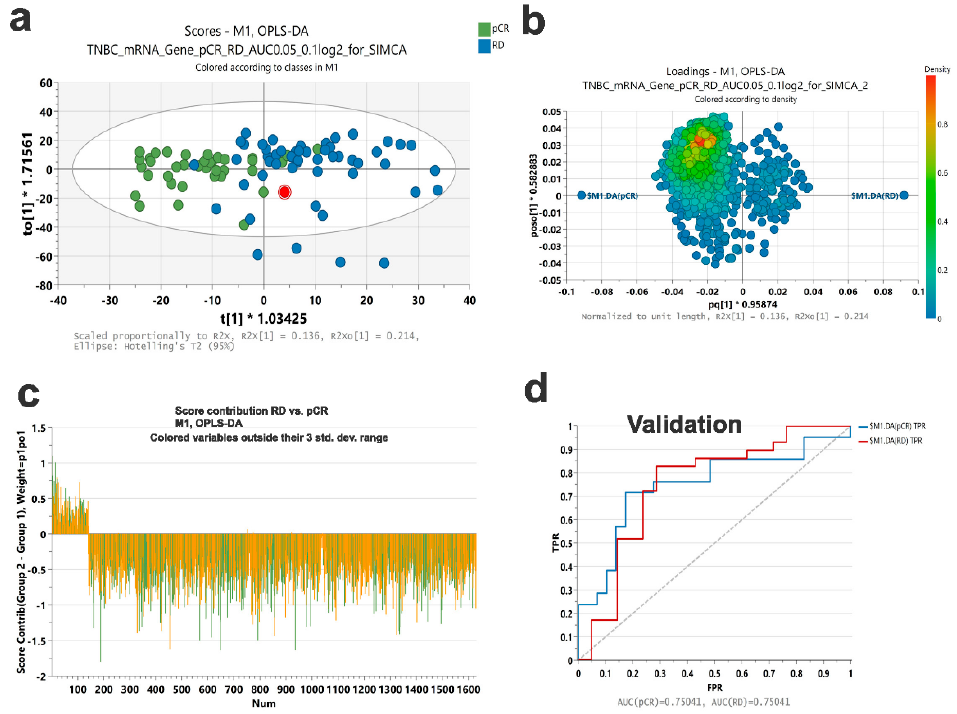
Figure 5. Validation of a gene signature predictive of RD and pCR in TNBC. ( a ) OPLS-DA score plot of a RD and pCR gene signature based on ROC analysis. ( b ) Loading plot based on SIMCA OPLS-DA analysis. Variables are colored according to their density score. ( c ) Score contribution plot illustrating the contribution of each variable in the model. ( d ) ROC analysis of the identified gene signature predictive of RD and pCR in an independent validation cohort consisting of 29 RD and 21 pCR. The y -axis represents FPR while the x -axis represents TPR.